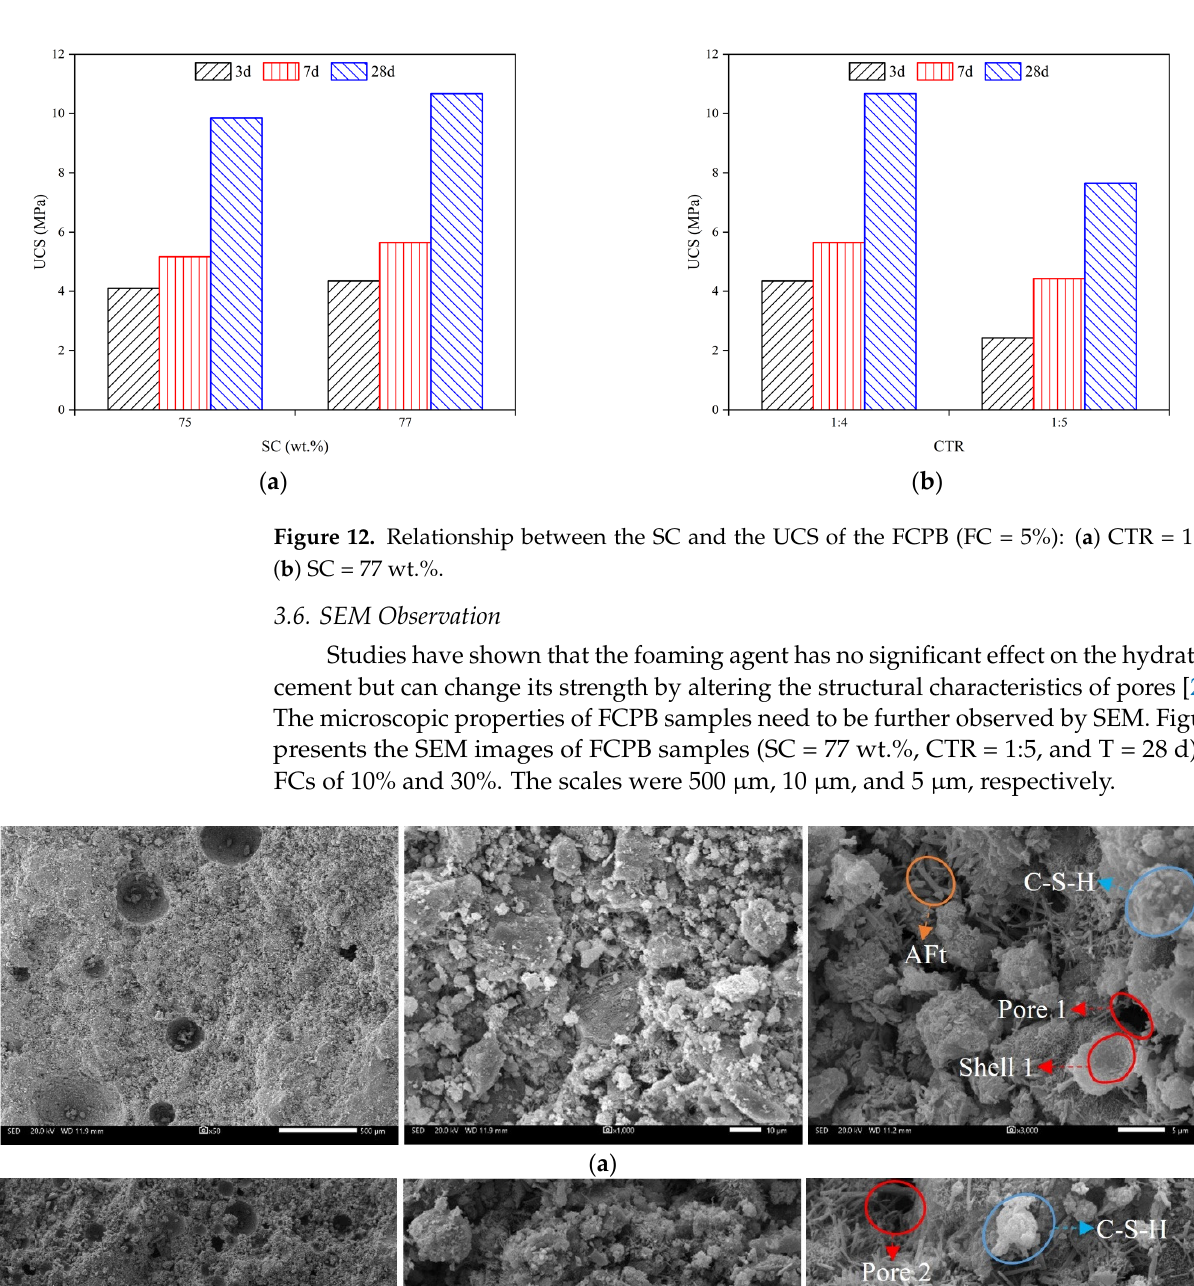
Figure 14. Microstructure of an FCPB sample. 4. Conclusions